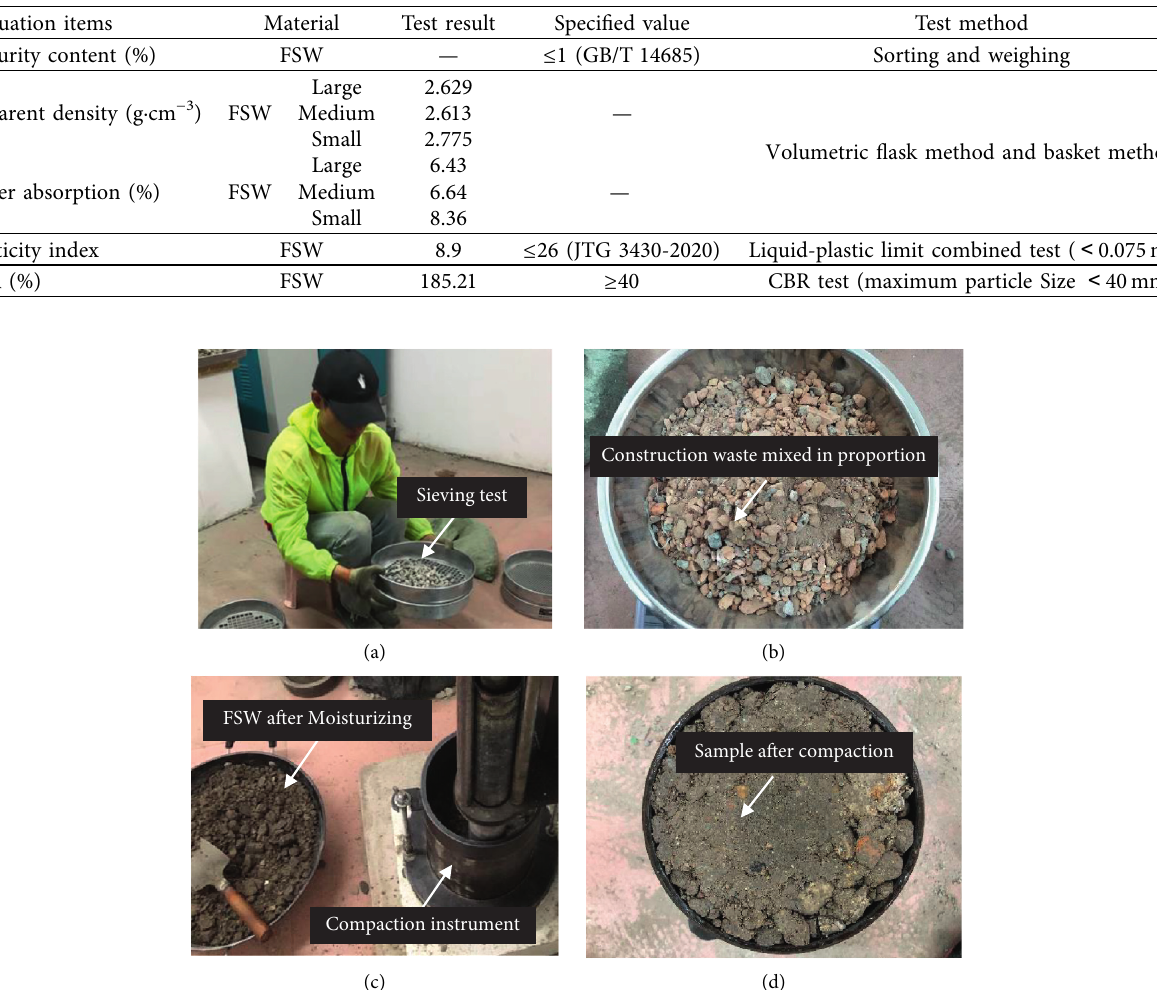
Table 1: Test results of FSW materials.